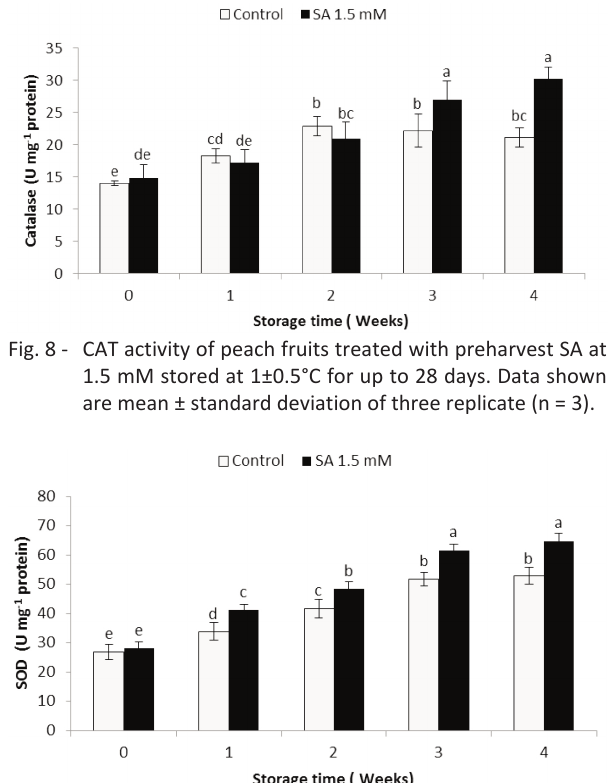
Fig. 9 - SOD activity of peach fruits treated with preharvest SA at 1.5 mM stored at 1±0.5°C for up to 28 days. Data shown are mean ± standard deviation of three replicate (n =